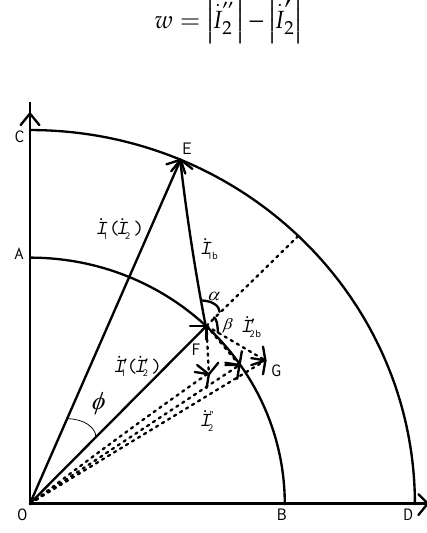
( 𝐹𝐸 ⃗⃗⃗⃗⃗⃗ in Figure 9) for the sensitive load. The